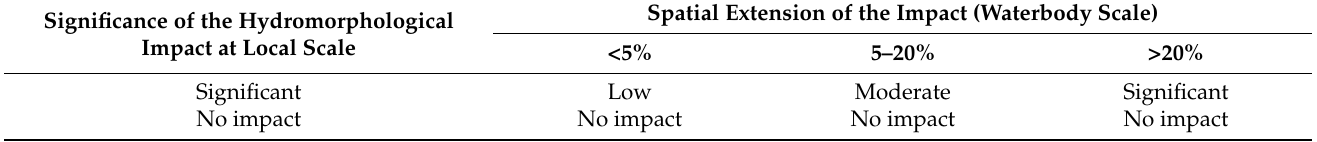
Table 3. The matrix for establishing the impact significance at the waterbody level based on the spatial extension of the